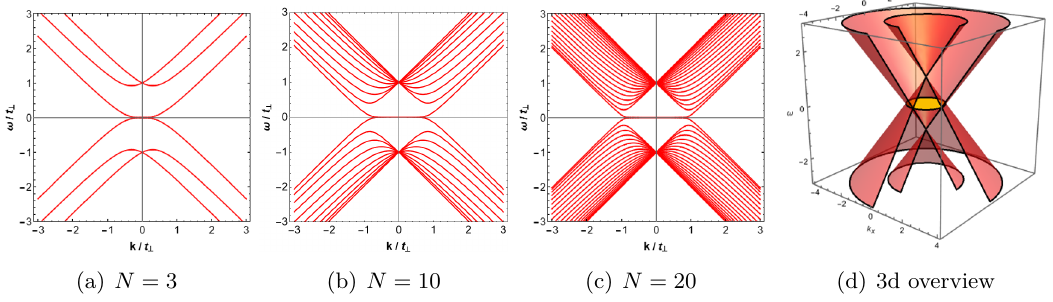
Figure 3 . Self-consistent band structure of ABC-MLG with N layer stacking. In (d), the orange disk at the center is the flat band of size R tb . We used t ⊥ = 1 and U j = 0